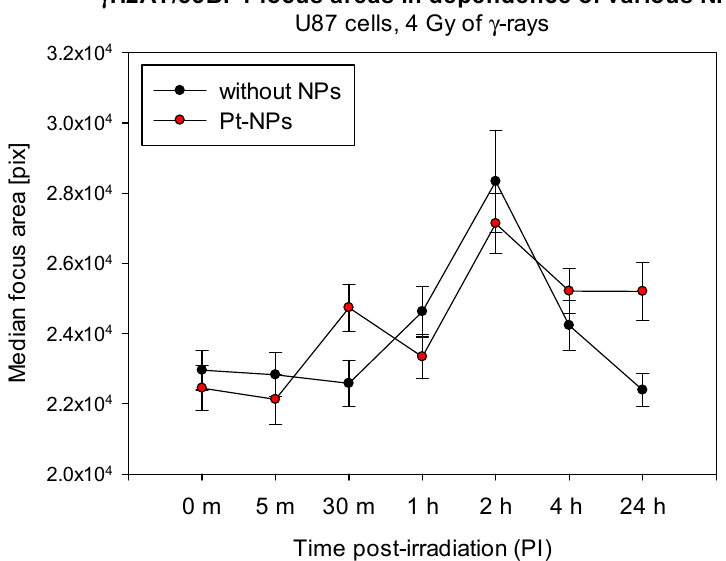
Figure 12. Comparison of γ H2AX/53BP1 focus areas at different periods of time PI compared for U87 cells irradiated with 4 Gy of γ -rays in absence or presence of Pt-NPs. The results of an automated software analysis are shown as mean numbers of pixels per focus. Black circles—without NPs, and red circles—Pt-NPs (0.5 mM, 6 h-incubation; preliminary results). Error bars = standard error, m = minutes, pix = pixels, 0 m = non-irradiated samples.